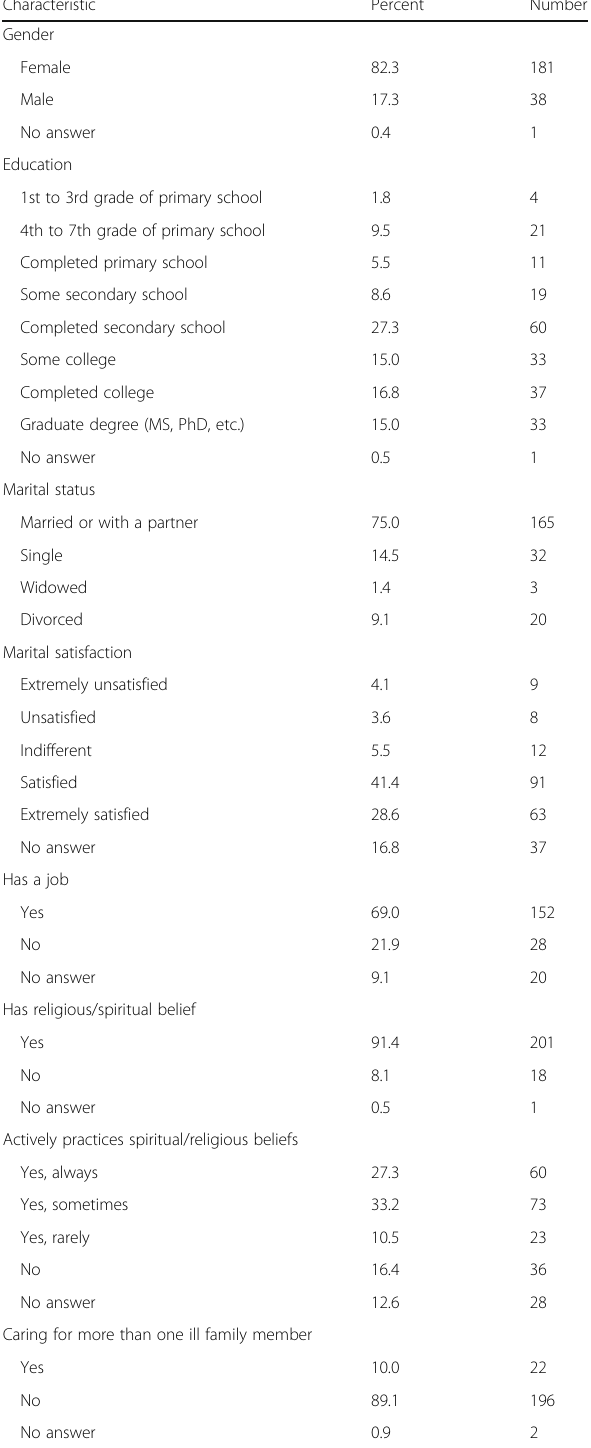
Table 1 Sociodemographic characteristics of the